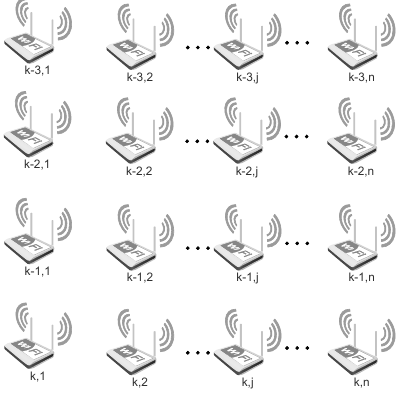
Figure 4. The multi-dimensional WiFi fingerprint